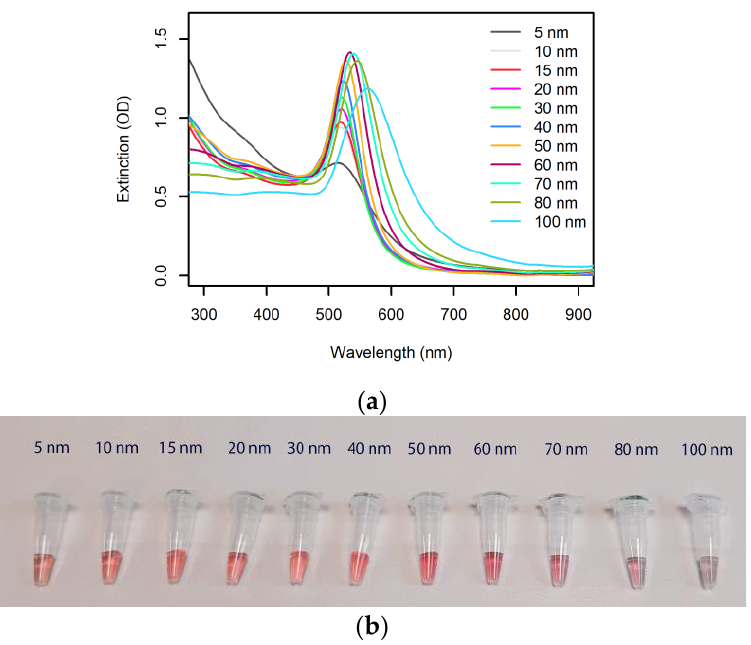
Figure 2. Optical properties of spherical AuNPs. ( a ) Extinction spectra (1 cm pathlength) of commercial 50 μ g/mL citrate-capped AuNP colloids (nanoComposix, San Diego, CA, USA). ( b ) Photograph of the AuNP solutions from panel a.